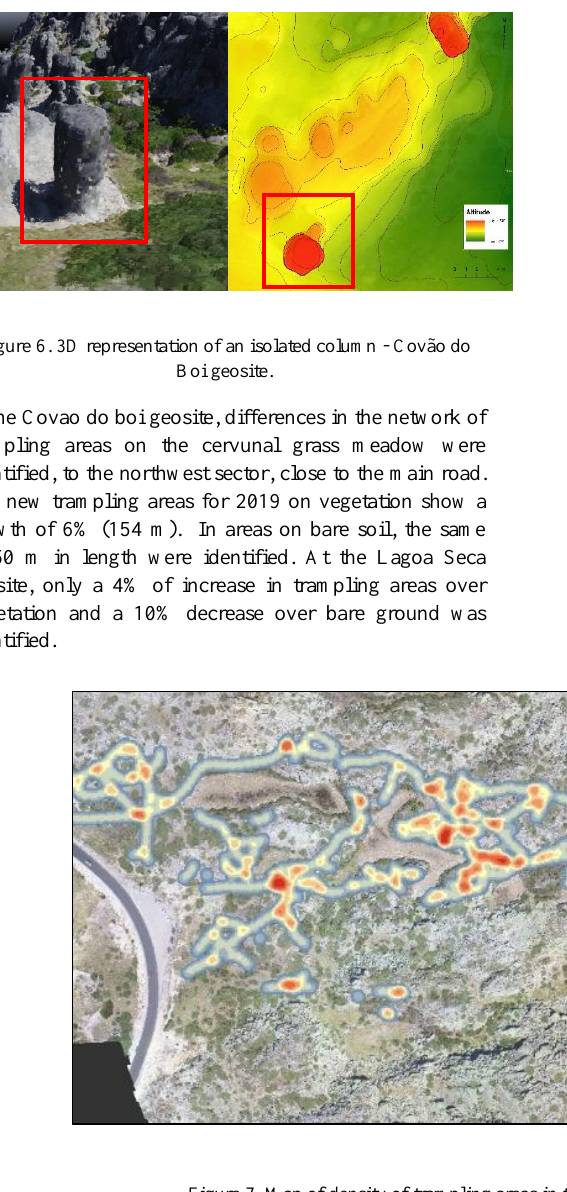
Figure 7. Map of density of trampling areas in the Salgadeiras - Covão da Clareza